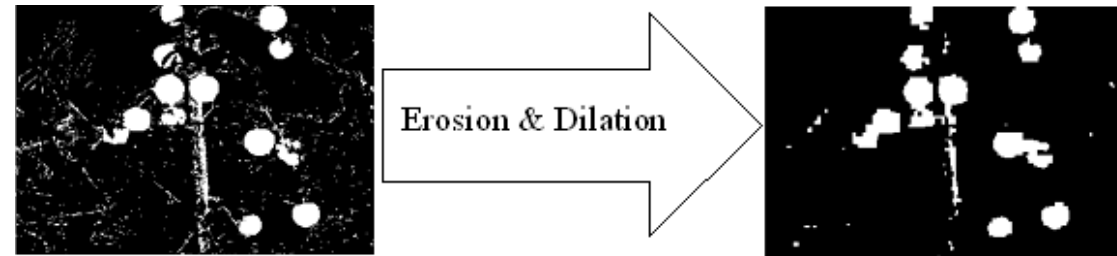
Figure 8. Morphological